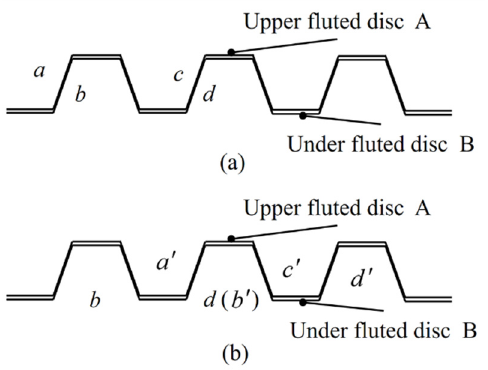
Figure 2. The meshing state of the end gear. ( a ) Before rotating. ( b ) After rotating.